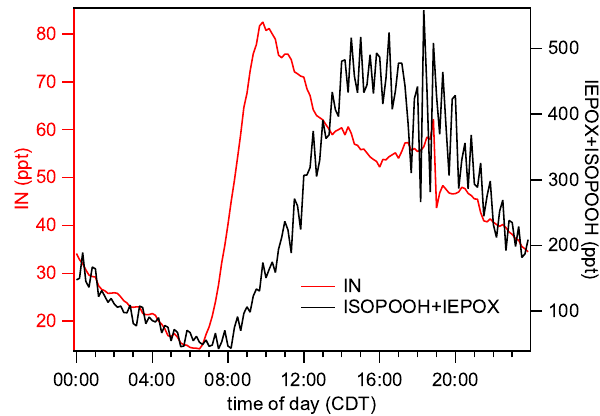
Figure 10. Diurnal averages of IN and ISOPOOH + IEPOX from 30 May to 4